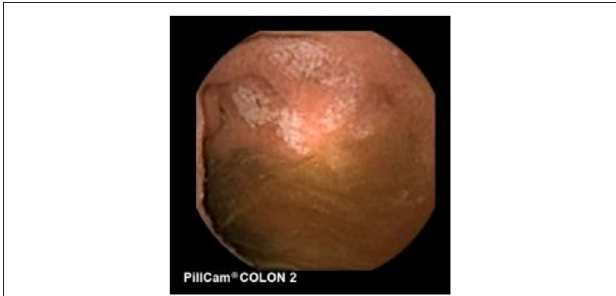
FIGURE 13 | Ampulla of vater.